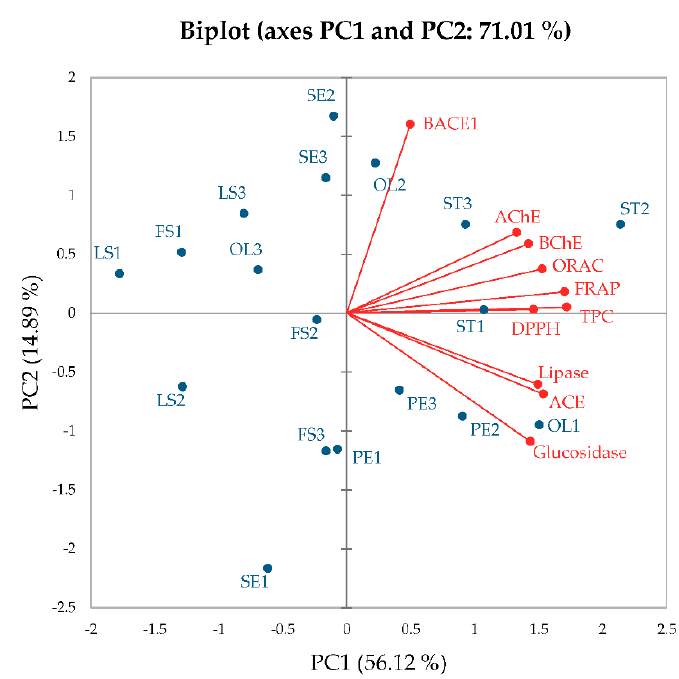
Figure 2. Biplot of principal component analysis (PCA) generated from the observations including seed embryo (SE), petal (PE), old leaf (OL), stamen (ST), flower stalk (FS) and leaf stalk (LS) har- vested from different time periods (1: time period 1; 2: time period 2; 3: time period 3) and variables including total phenolic contents (TPCs), antioxidant activities (FRAP, DPPH radical-scavenging and ORAC activities) and enzyme inhibitory activities against β-secretase (BACE-1), acetylcholin- esterase (AChE), butyrylcholinesterase (BChE), angiotensin-converting enzyme (ACE), α-gluco- sidase and